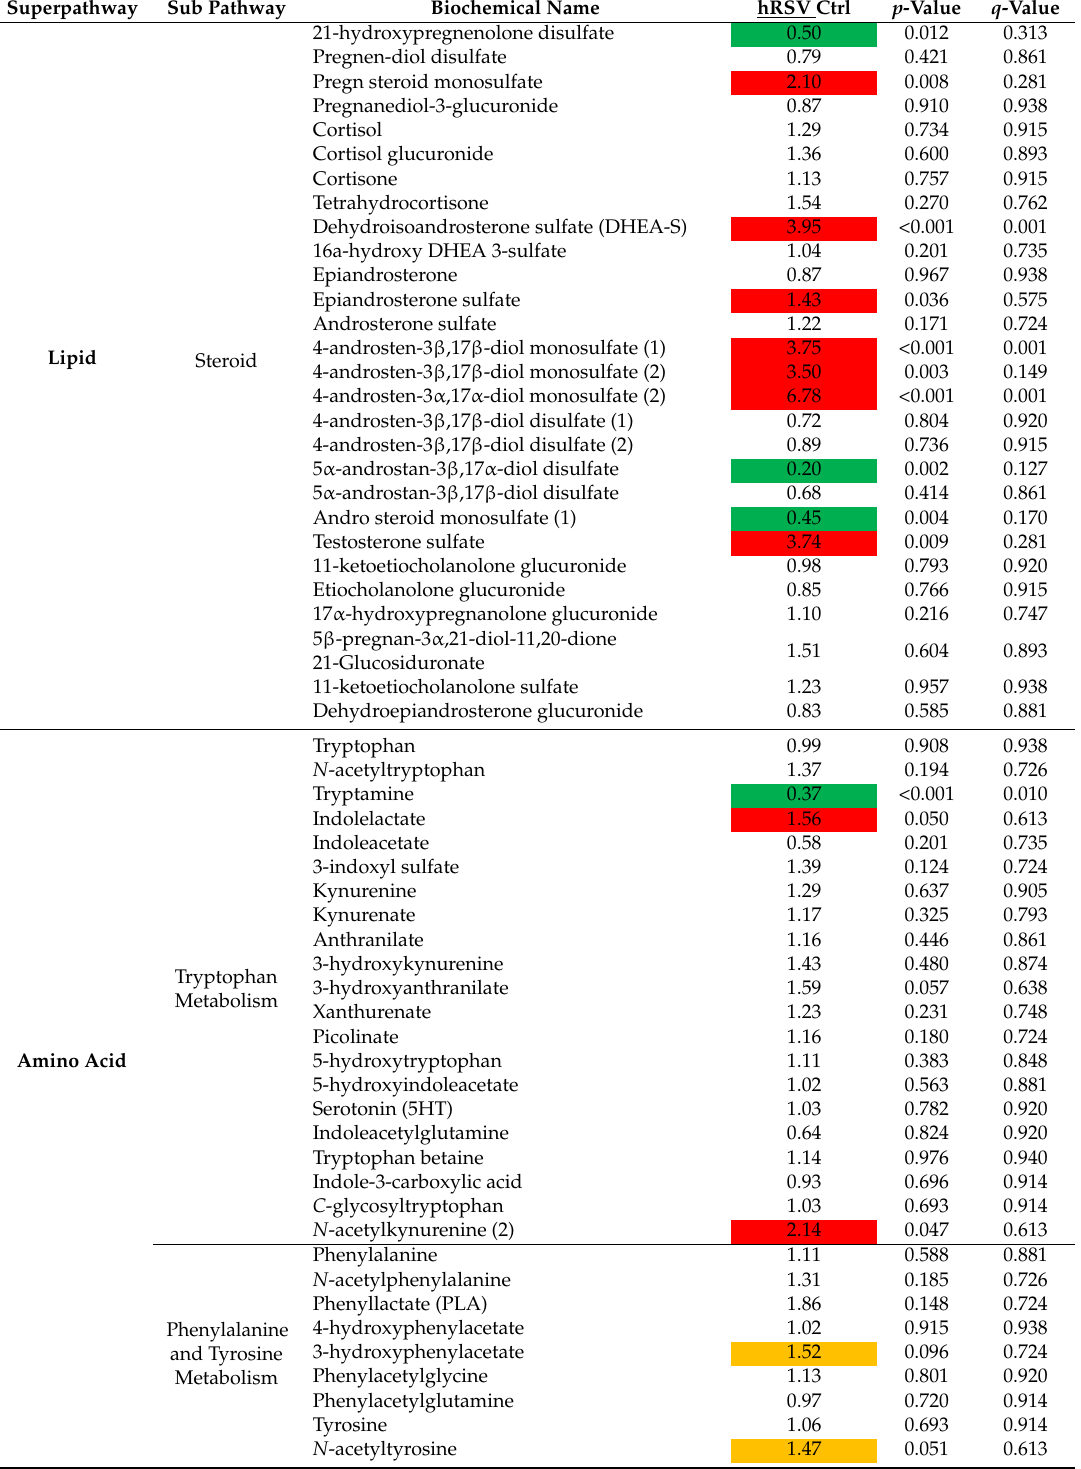
Table 5. Summary of resveratrol-induced changes in urine. Identified metabolites in the steroid, tryptophan metabolism, phenylalanine and tyrosine metabolism, and histidine metabolism pathways in urine. Red: Significant elevation ( p ≤ 0.05). Orange: Trending elevation ( p < 0.10); Green: Significant reduction ( p ≤